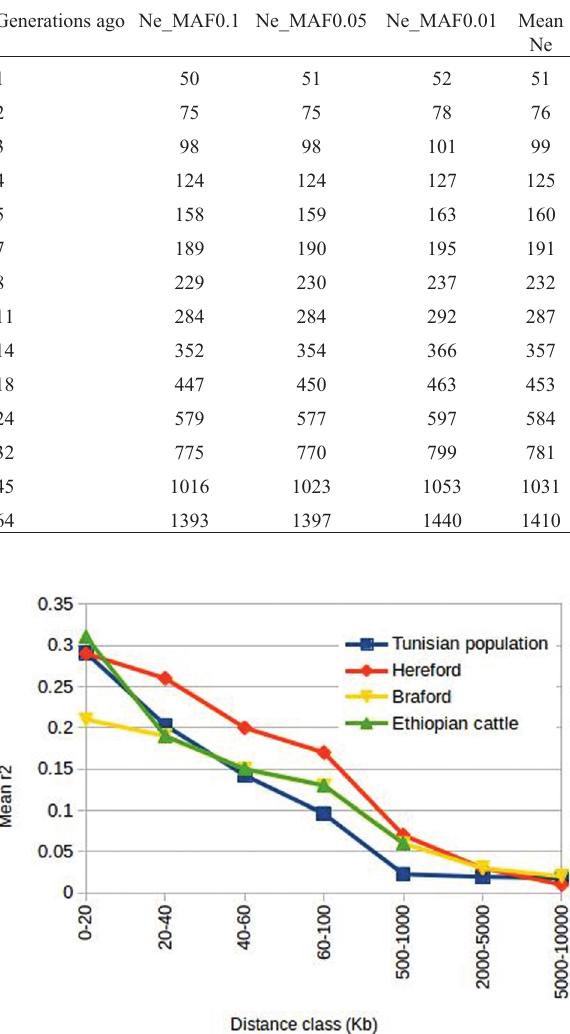
Table 3 - Average estimated effective population size truncated at 64 gen- erations for three different MAF thresholds.